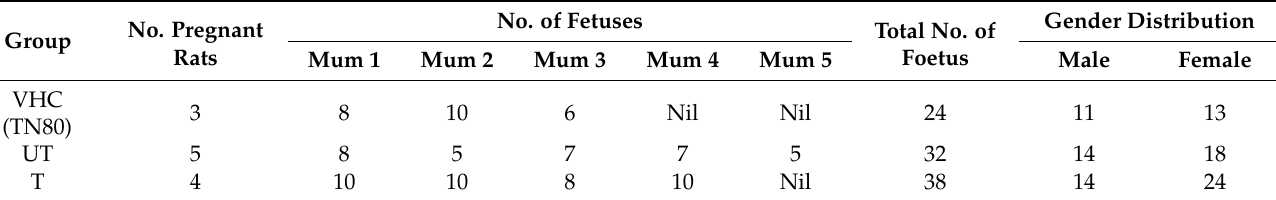
Table 1. Number of fetuses and gender